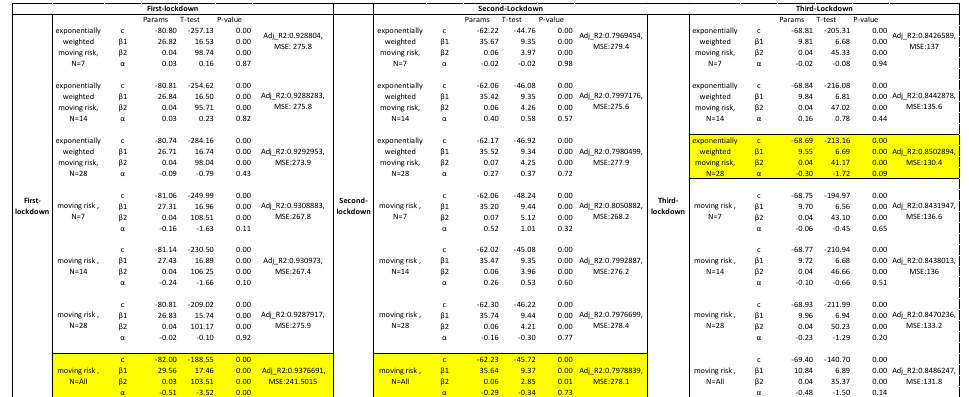
od. Figure A5 is the summary of all experiments for the linear model. The complete excel files are saved as supporting materials.